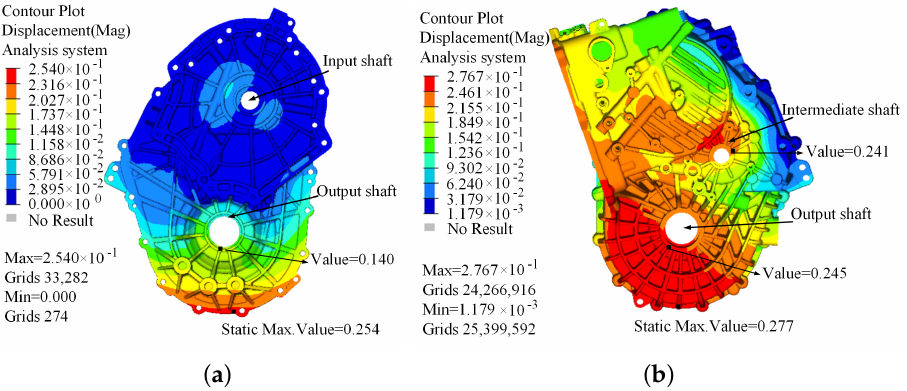
Figure 16. ( a ) Deformation of front gearbox housing after optimization. ( b ) Deformation of rear gearbox housing after optimization.